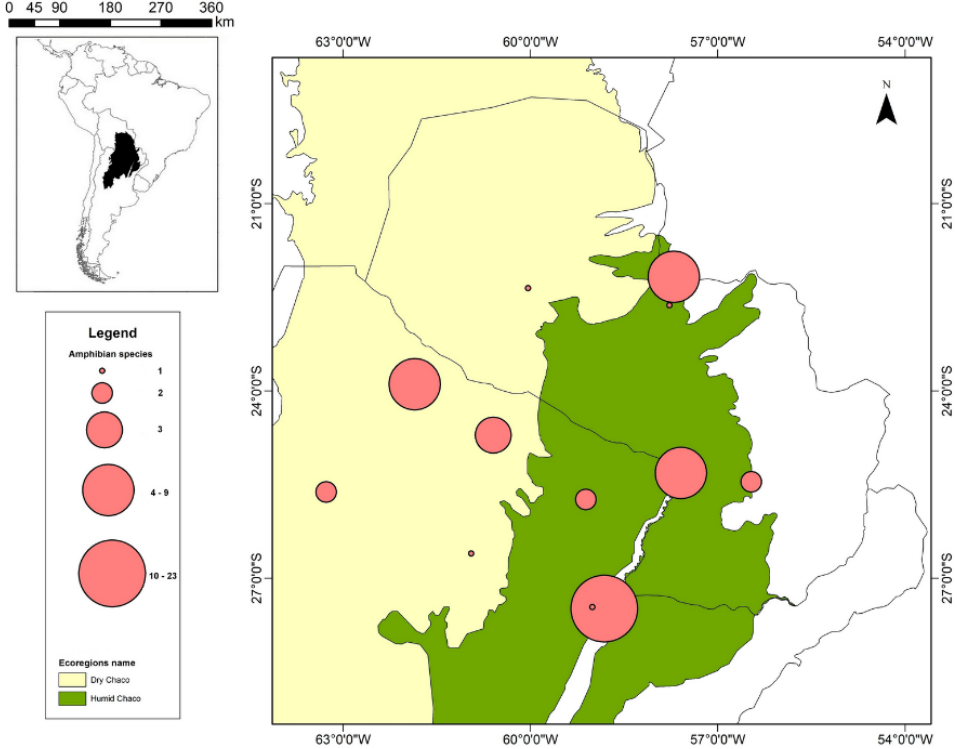
Figure 2. Number of amphibian species analyzed for nematode parasites in twelve localities in Dry and Humid Chaco ecoregions. Corrientes: Rhinella bergi , R. diptycha , R. dorbignyi , R. major , Boana raniceps , Dendropsophus nanus , D. sanborni , Lysapsus limellum , Pseudis platensis , Scinax acuminatus , S. nasicus , Leptodactylus bufonius , L. elenae , L. latinasus , L. luctator , L. macrosternum , L. podicipinus , Physalaemus albonotatus , P. santafecinus , Pseudopaludicola falcipes , P. boliviana , Odontophrynus americanus , Pithecopus azureus ; Resistencia: Melanophryniscus klappenbachi ; Piran é : Trachycephalus typhonius , P. azureus ; Asunci ó n: R. diptycha , L. bufonius , L. luctator, L. elenae , L. mystacinus , P. azureus ; Coronel Oviedo: L. elenae , L. fuscus ; Puerto Max: L. macrosternum ; Estancia Estrellas: R. diptycha , R. major , L. bufonius , L. elenae , L. podicipinus ; Boquer ó n: R. major ;